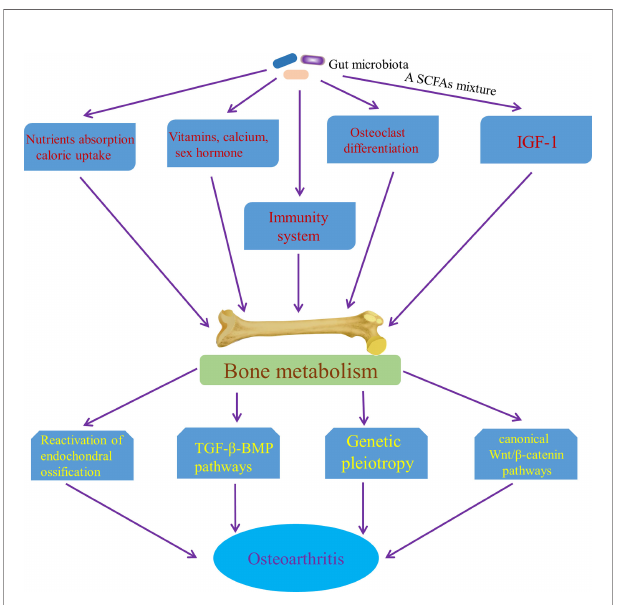
FIGURE 7 | Pathways of the effect of gut microbiota on OA though affecting bone metabolism. SCFAs mixture, a short chain fatty acids mixture, containing acetate, butyrate and propionate; IGF-1, insulin growth factor-1; TGF- b -BMP pathway, the transforming growth factor b – bone morphogenetic protein signaling pathways.